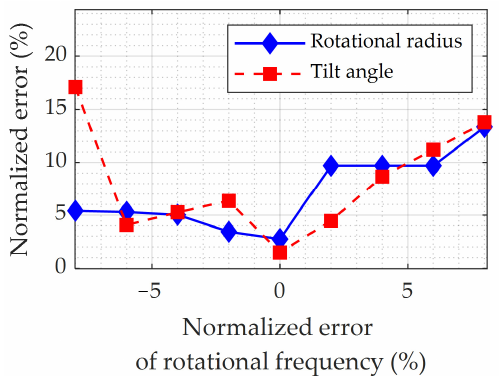
Figure 10. The variation of the real rotational radius and tilt angle estimation errors with the rota- tional frequency estimation error.